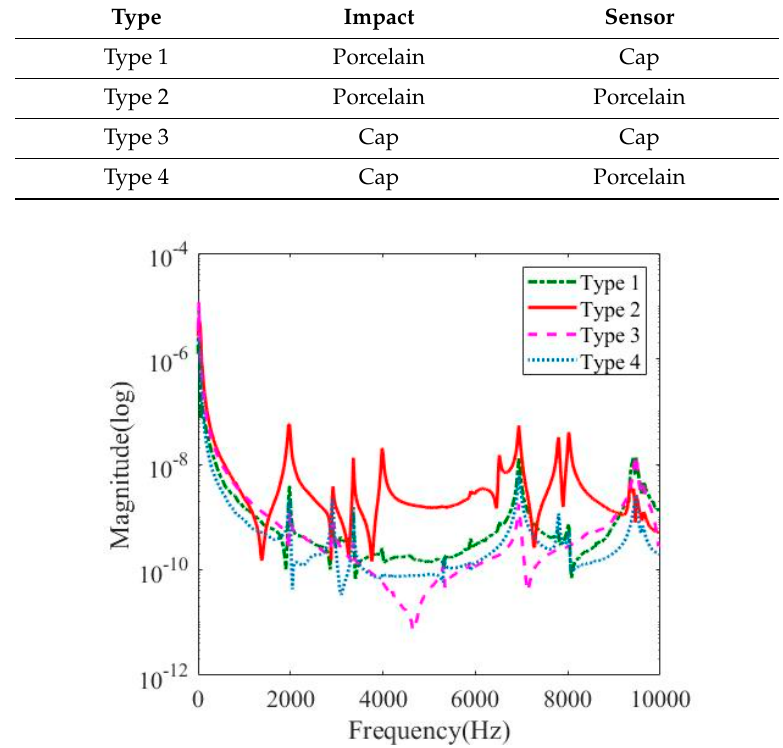
Figure 3. Frequency response function (FRF) results according to impact and sensor position.